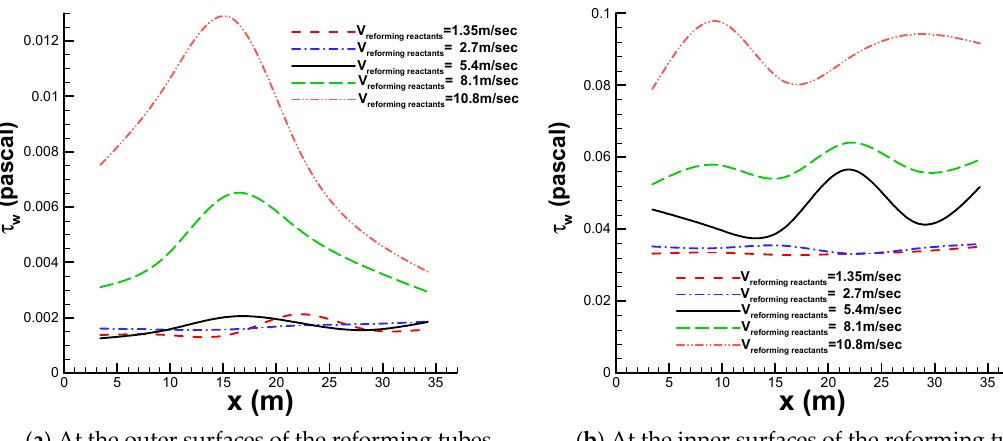
Figure 10. Comparison of the average wall shear stresses at the surfaces of the reforming tubes using different inlet velocities of the reforming reactants.